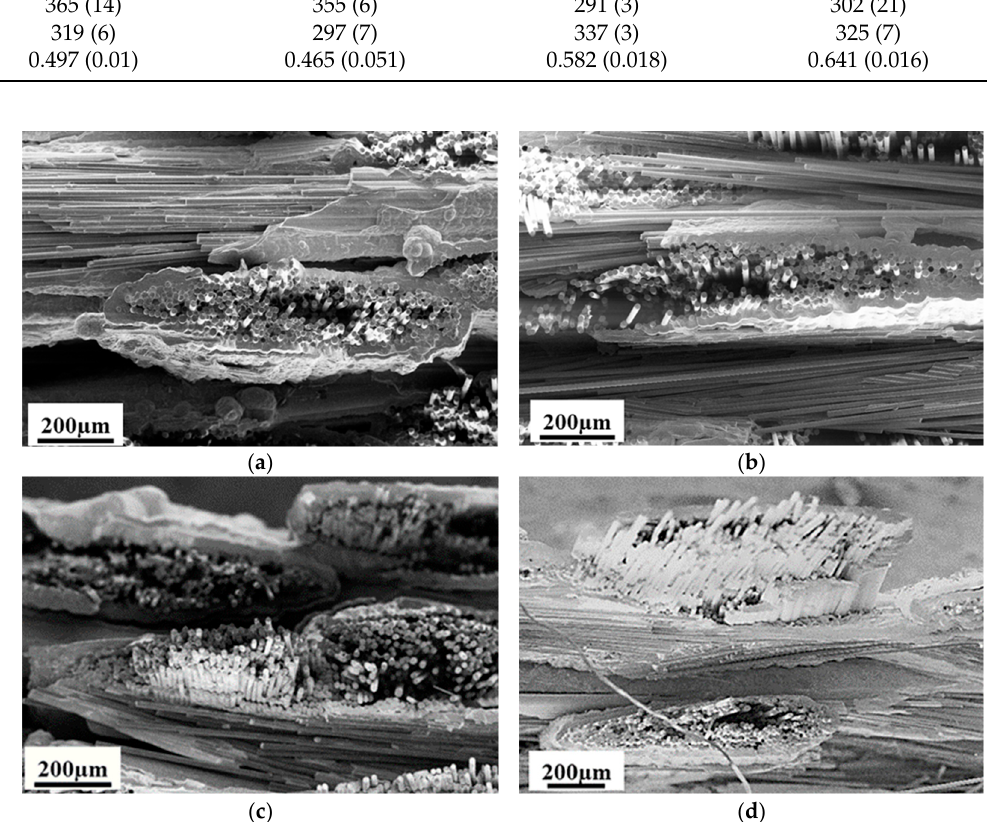
Figure 8. Fracture surface after failure for each type of composites specimen: ( a ) HNS/PyC HA30nm /SiC, ( b ) HNS/PyC HA150nm /SiC, ( c ) HNS/PyC LA30nm /SiC and ( d ) HNS/PyC LA150nm /SiC.